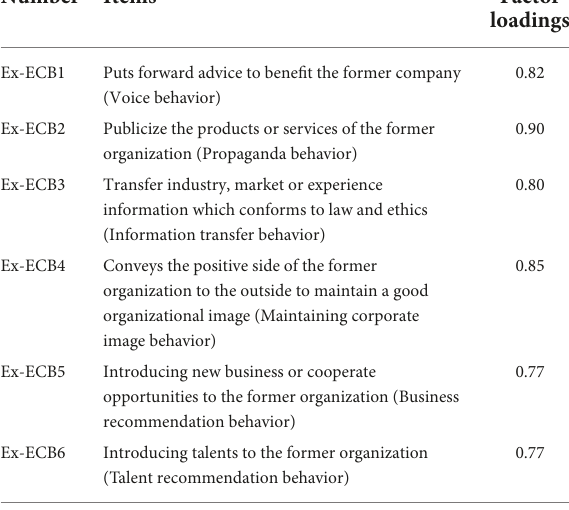
TABLE 1 Items and factor loadings from confirmatory factor